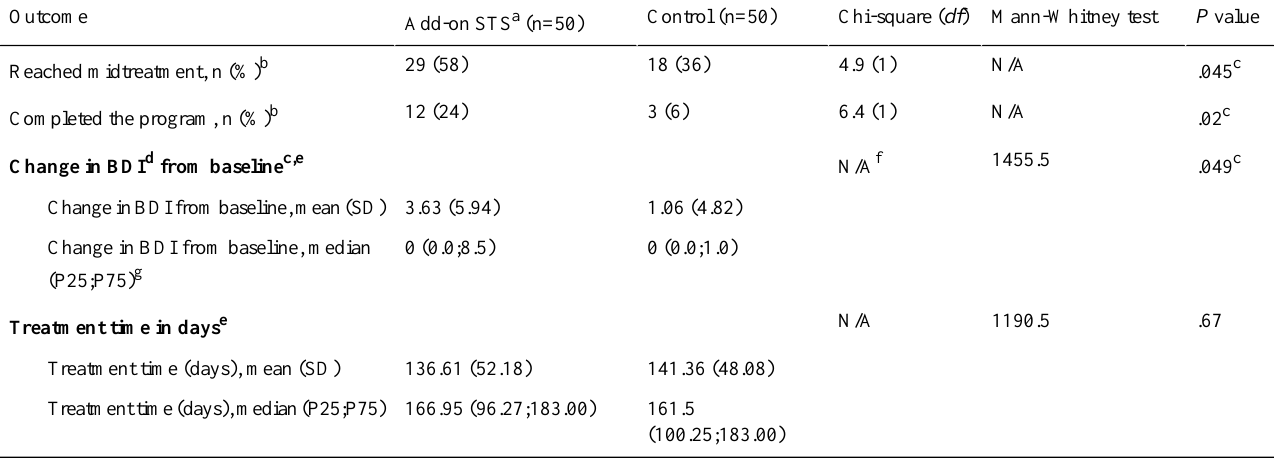
Table 4. Effects of add-on STS on adherence, depression, and time in